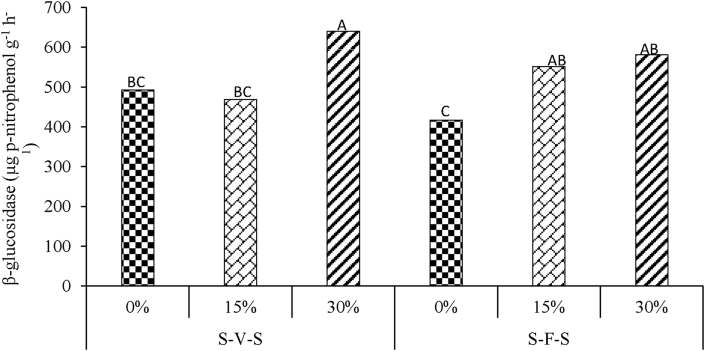
Rotation × residue management interaction effects on β-glucosidase activity. Different uppercase letters indicate significant differences at P ≤ 0.05. S-V-S: sweet sorghum-grazing vetch-sweet sorghum, S-F-S: sweet sorghum-fallow- sweet sorghum.